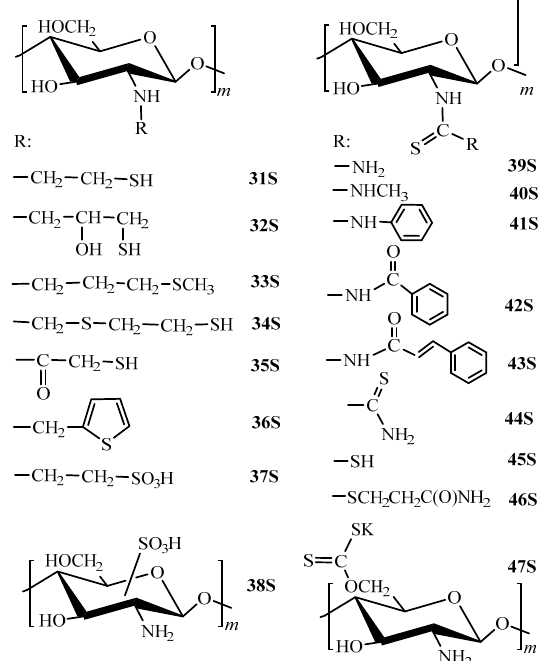
Figure 3. Structure of S-containing derivatives of chitosan without linkers: 31S —chitosan ethylenesulfide ( N -2-mercaptoethylchitosan); 32S — N -(2-hydroxy-3-mercapto)propyl chitosan; 33S — N -3-(methylthio) propyl chitosan; 34S —chitosan derivative of 1,2-ethanedithiol ( N -(4-mercapto-2-thiobutyl) chitosan);